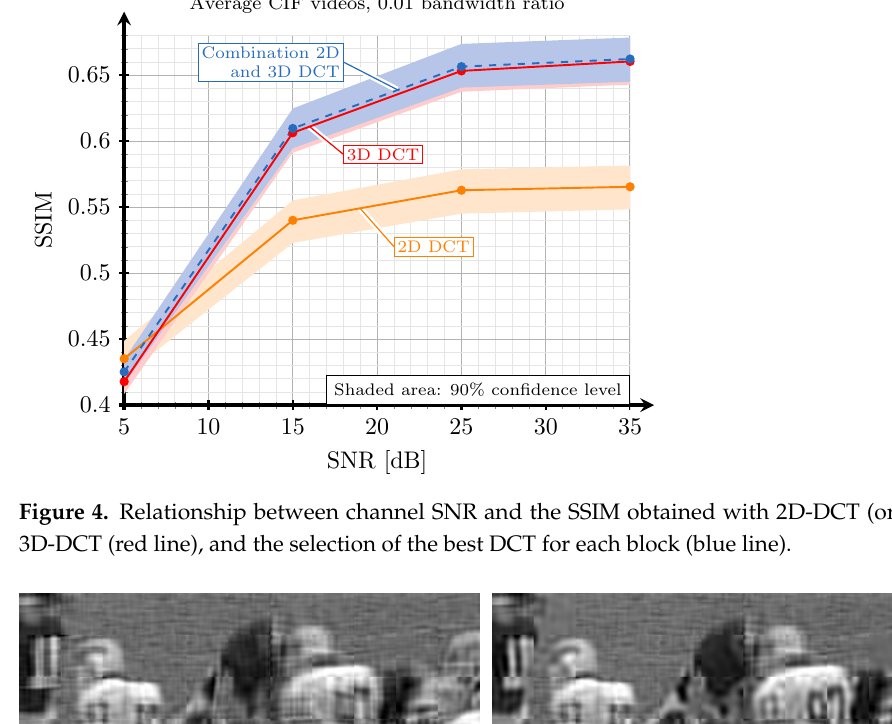
Figure 4. Relationship between channel SNR and the SSIM obtained with 2D-DCT (orange line), 3D-DCT (red line), and the selection of the best DCT for each block (blue line).